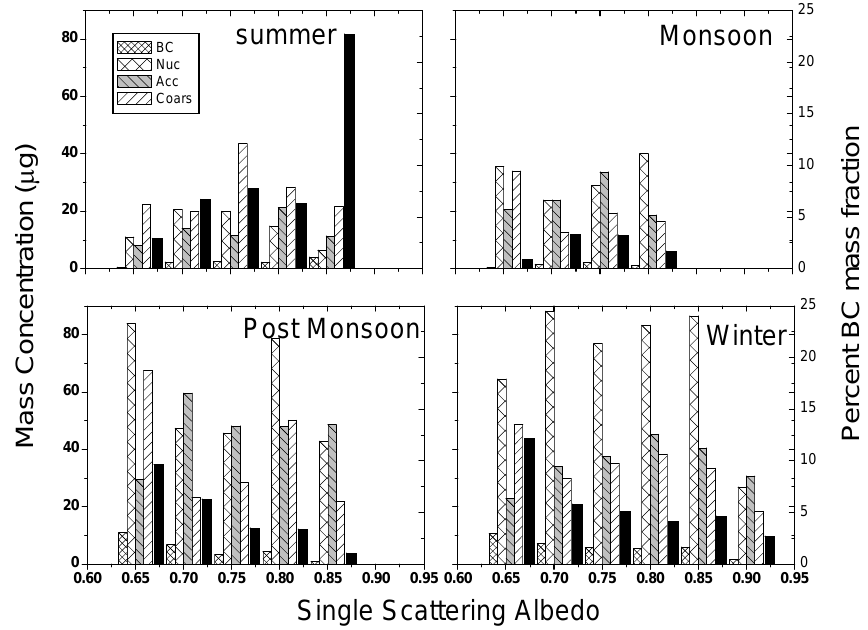
Fig. 5. Surface level size segregated (nucleation, accumulation, and coarse modes) mean aerosol mass concentrations (in µgm − 3 ) measured using QCM system along with simultaneous mean BC mass concentrations (in µgm − 3 ) using the 7 channel Aethalometer as a function of the observed SSA (at 550nm) during summer, monsoon, post-monsoon, and winter seasons. Also shown is the percent BC mass fraction in fine mode aerosol (dark bar).